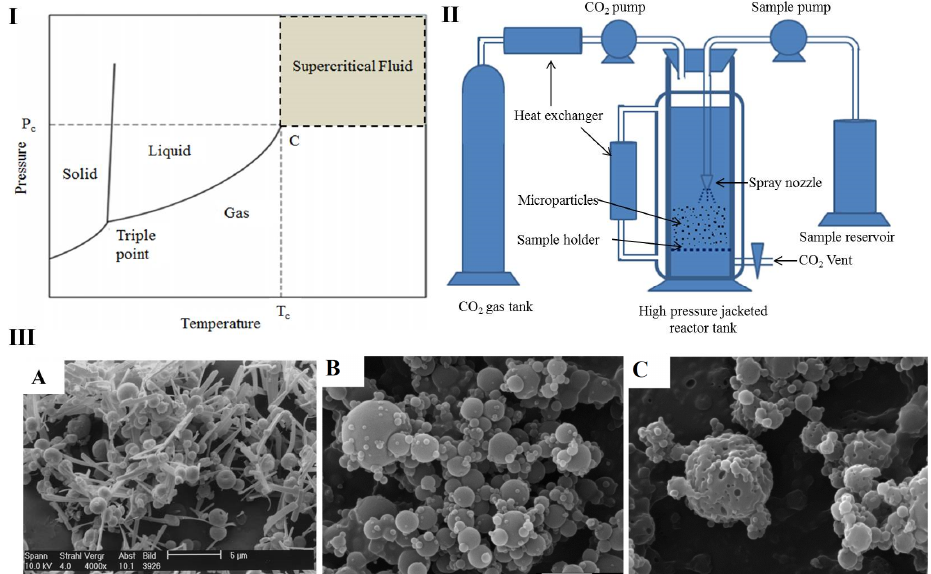
Figure 6. Preparation of dry powder for inhalation by supercritical fluid drying. ( I ) Chemical substance phase diagram (C: critical point) Reproduced with permission from [132], Elsevier, 2015; ( II ) schematic diagram of rapid expansion of supercritical fluid (RESF)-CO 2 technique; ( III ) SEM images of some supercritical fluid (SF)-dried products ( A ) fluticasone with 5% lecithin Reproduced with permission from [139], Elsevier, 1998, ( B , C ) CHT and CHT-IBP microparticles Reproduced with permission from [141], Elsevier,